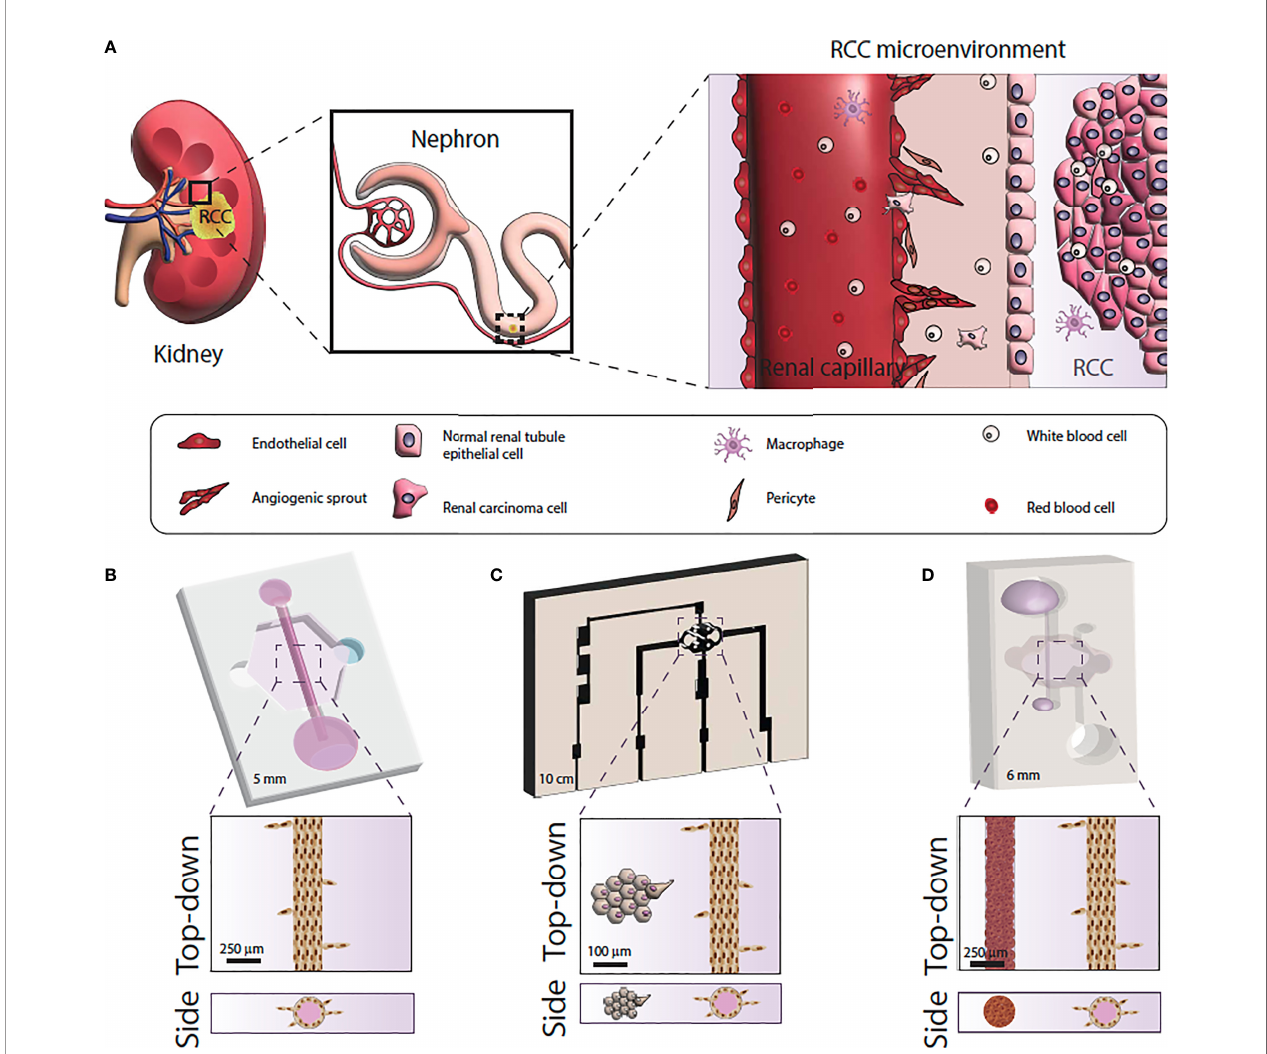
FIGURE 2 | Micro fl uidic model systems used for renal cell carcinoma research. (A) Schematic of the RCC tumor microenvironment. (B) Micro fl uidic model of RCC response using primary normal and tumor-associated endothelial vessels. (C) Micro fl uidic model of RCC angiogenesis using primary epithelial-derived spheroids and Human Umbilical Cord Endothelial cell vessel models. (D) Micro fl uidic of RCC development and angiogenesis using RCC cell lines or primary epithelial cells and iPSC-derived endothelial cell